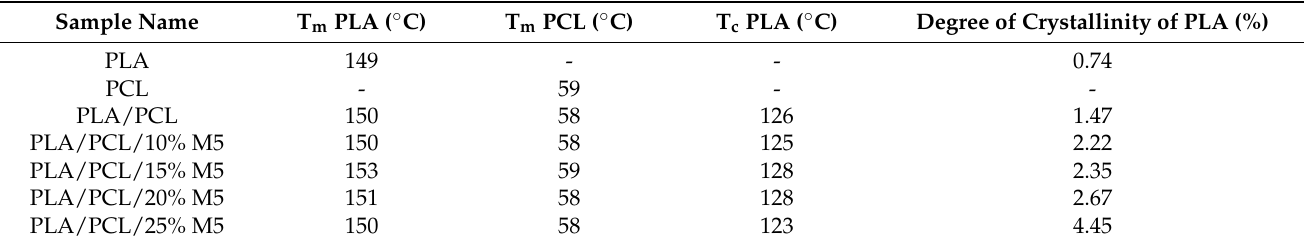
Table 4. The melting temperatures of PLA and PCL, the crystallization temperature of PLA, and the degree of crystallinity of PLA in the PLA pure polymer, the blend, and the composites.